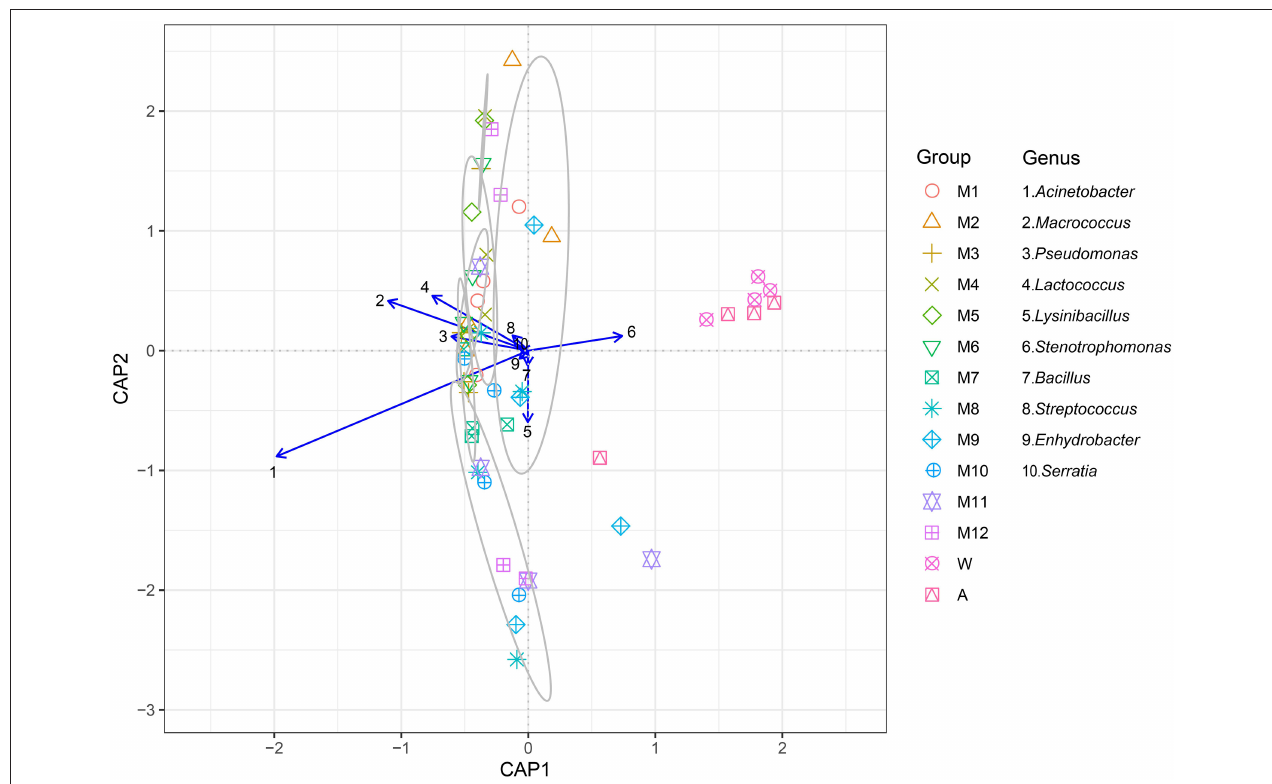
FIGURE 4 | The canonical analysis of principal coordinates (CAP) explained the correlation of the level of the 10 primary bacterial genera ( Acinetobacter, Macrococcus, Pseudomonas, Lactococcus, Lysinibacillus, Stenotrophomonas, Bacillus, Streptococcus, Enhydrobacter, and Serratia ) in different samples. The samples in the gray circle are regarded as a group because the similarity was > 70%. See Figure 1 for